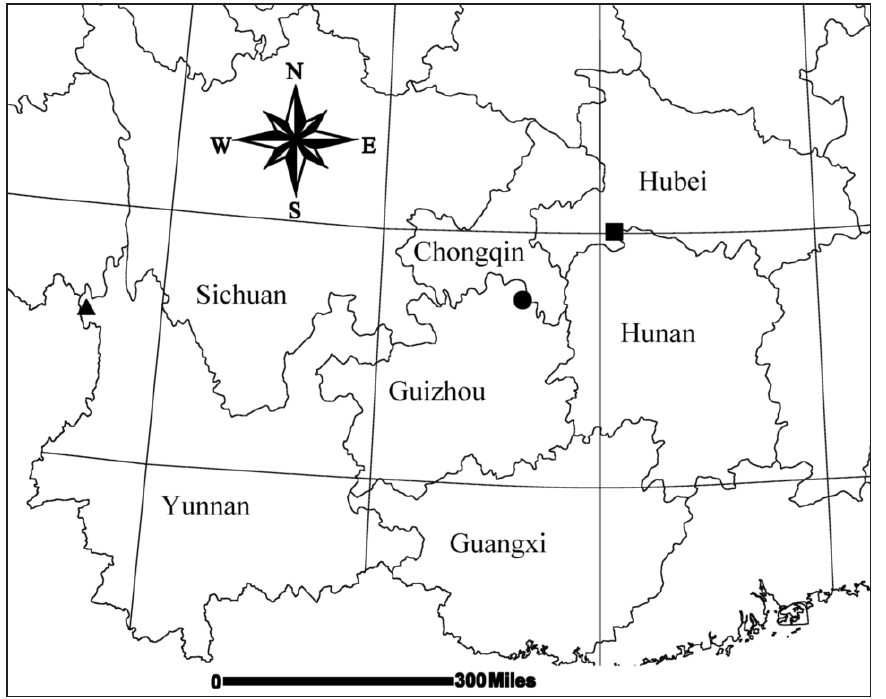
Figure 11. Collecting localities of three Mimetus species. ■ M. echinatus ; ● M. lamellaris sp. n.; ▲ M. wangi sp.